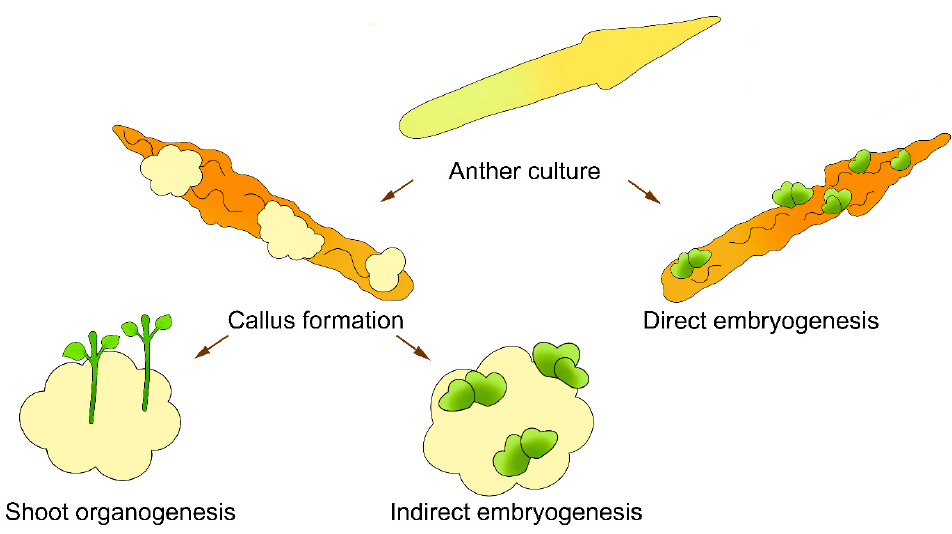
Figure 1. Morphogenic responses in sunflower anther culture.